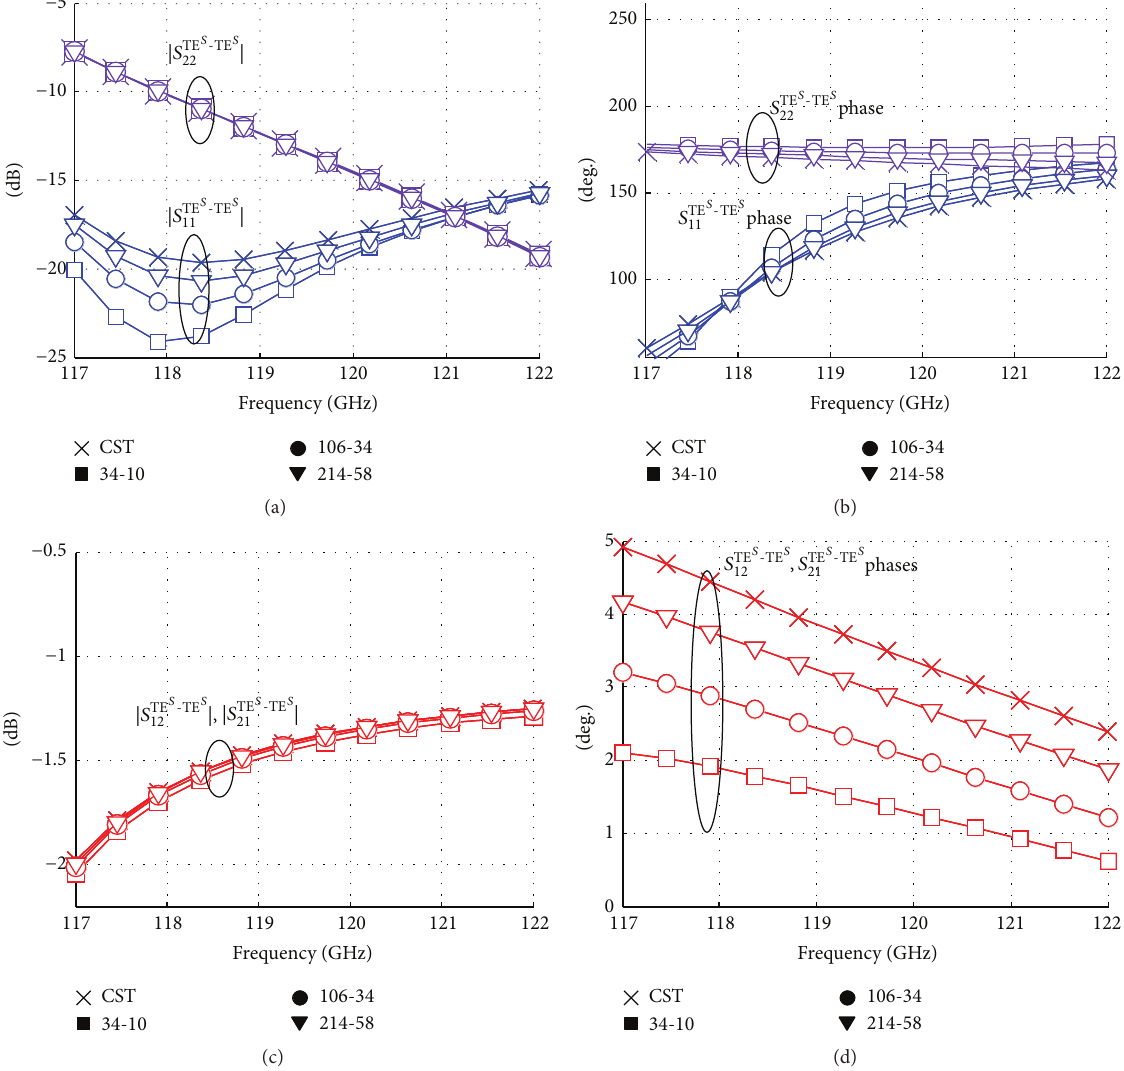
Figure 10: Case study b: mode TE 𝑆 10 in waveguide 1 to mode TE 𝑆 10 in waveguide 2 : (a) reflection magnitude, (b) reflection phase, (c) transmission magnitude, and (d) transmission